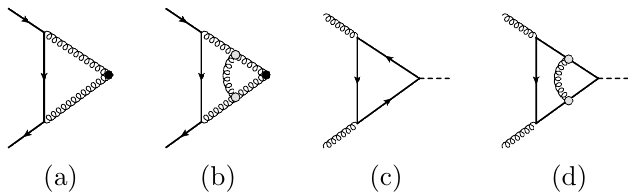
) 2 (cid:22)(cid:23)